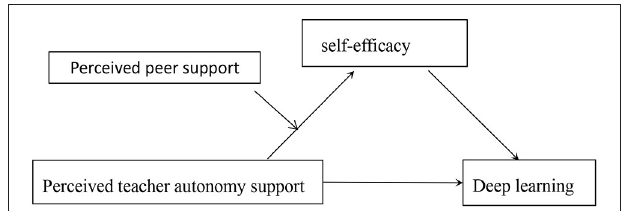
FIGURE 1 | The proposed moderated mediation